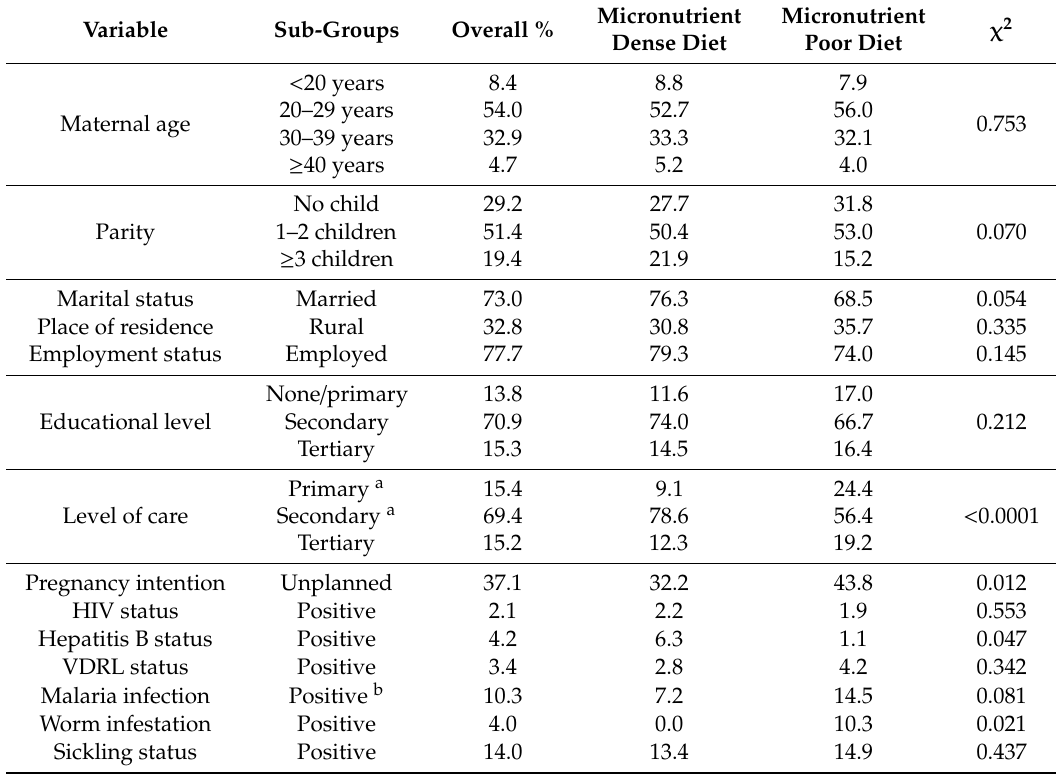
Table 1. Socio-demographic, nutritional status and health characteristics of the study participants stratified according to the adequacy of micronutrient